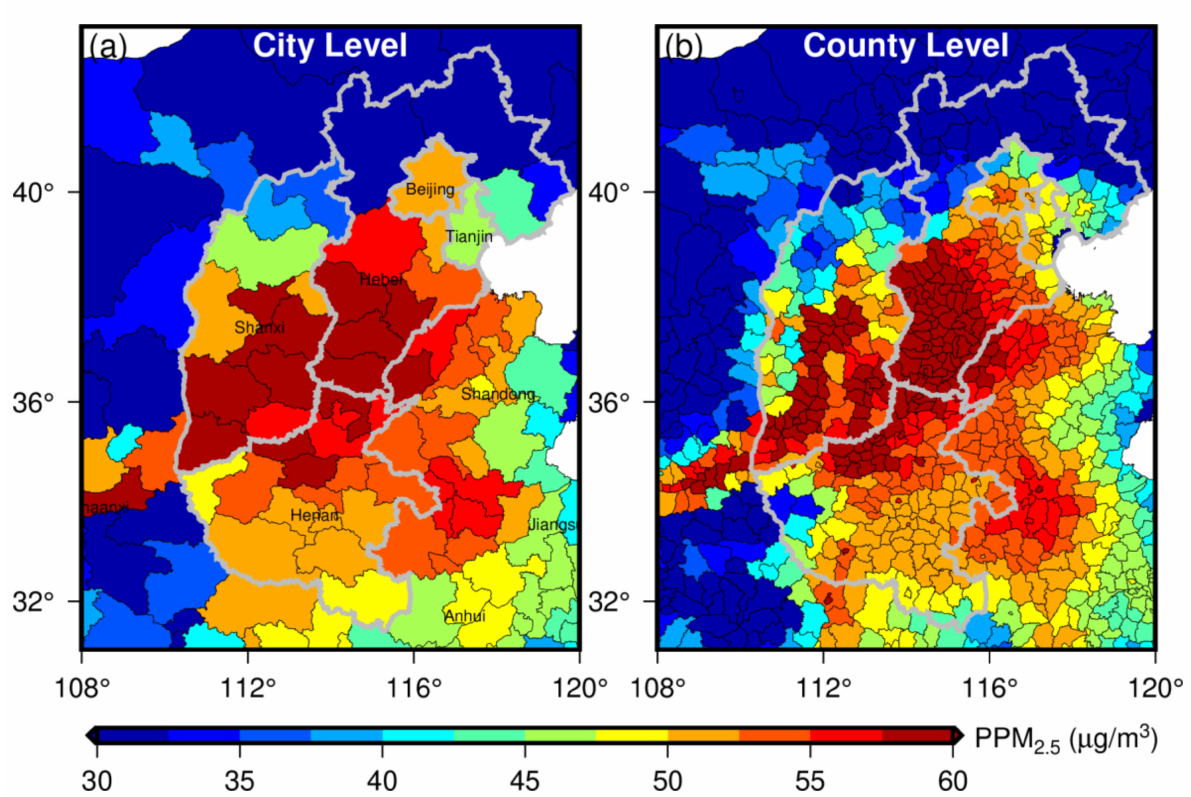
Figure 10. Spatial distributions of population weighted PM 2.5 (PPM 2.5 ) concentrations at the city and county levels in the North China